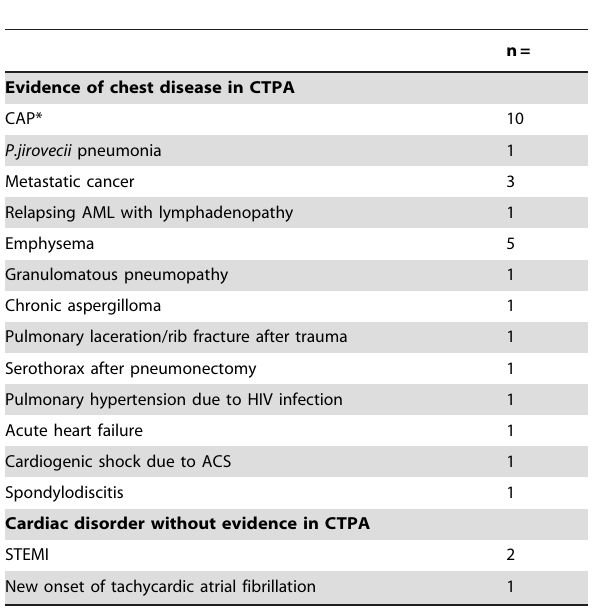
Table S1 Simplified Revised Geneva Score. Simplified